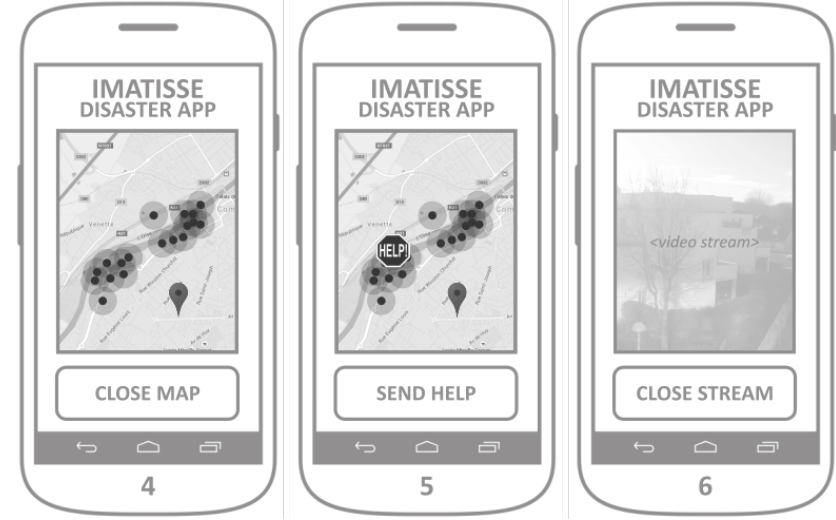
Figure 13. Crowd sensing